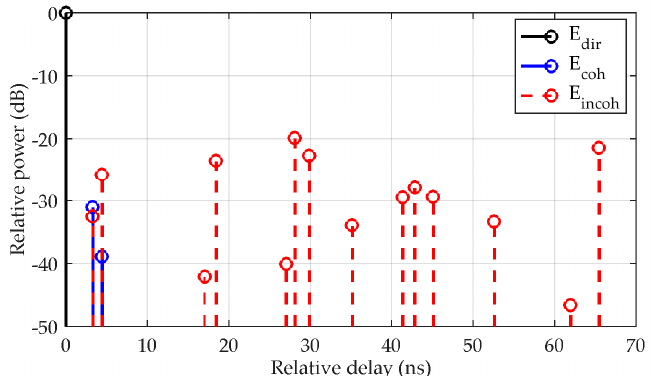
Figure 12. Generated CIR for the experimental scenario under LoS propagation conditions as achieved at the flight time 5 s. The direct signal (black line) dominates while the coherent fields (blue lines) scattered from the two canopies closest to Rx are negligible. The total incoherent scattered fields from each canopy (red dashed lines) are stronger than the coherent scattered fields as they dominate in other than the forward scatter direction. The power levels and time delays are normalized with respect to the direct signal between Tx and Rx.